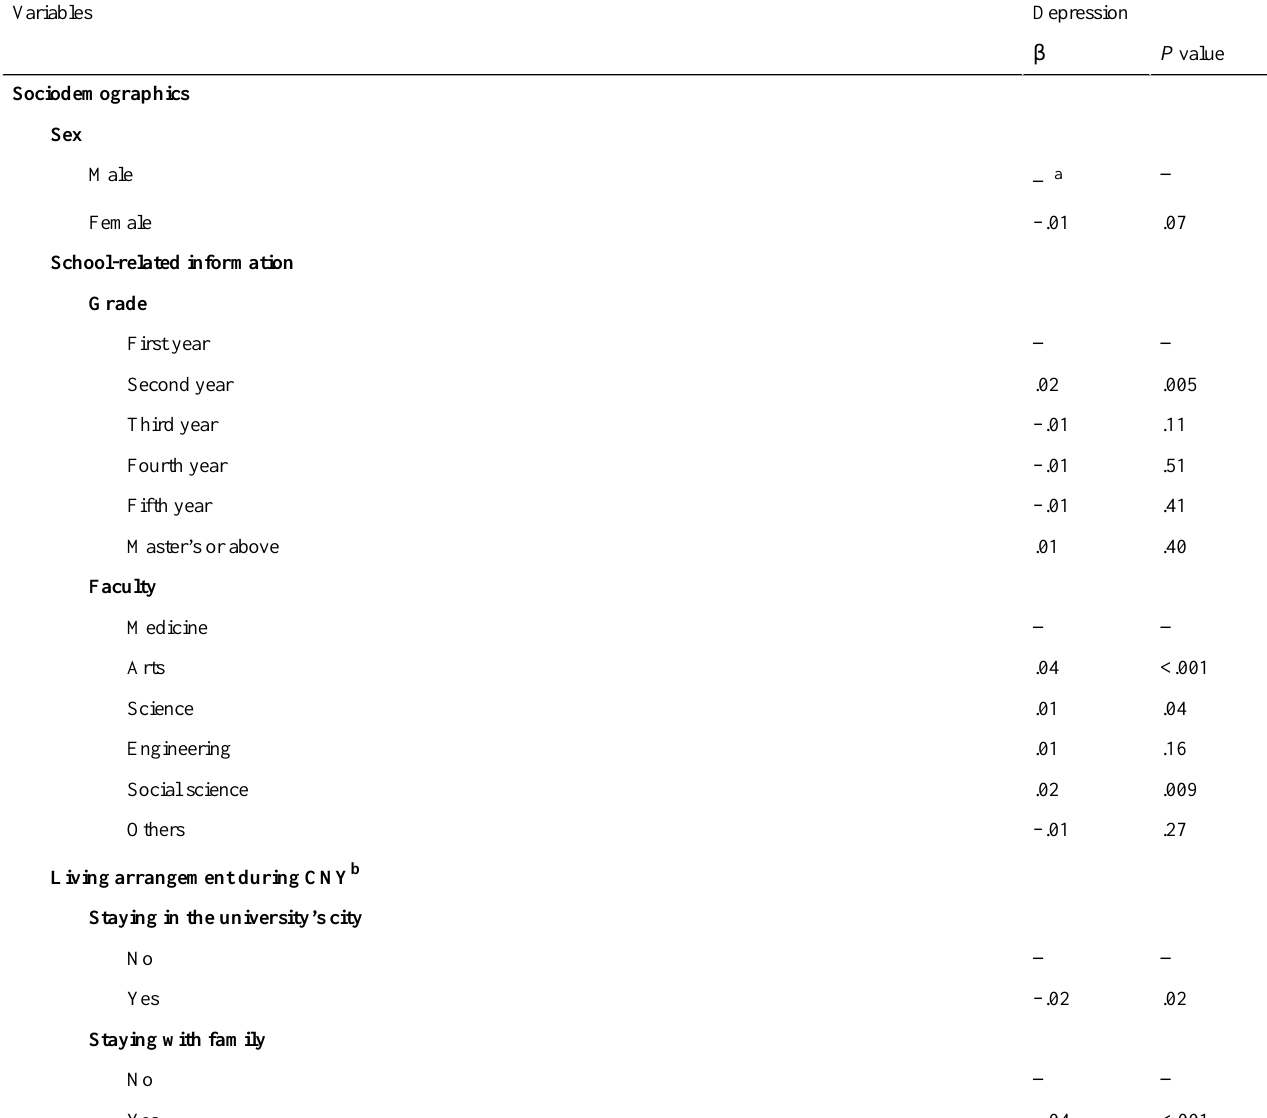
Table 3. Linear regression analyses on the associations between background variables and depression